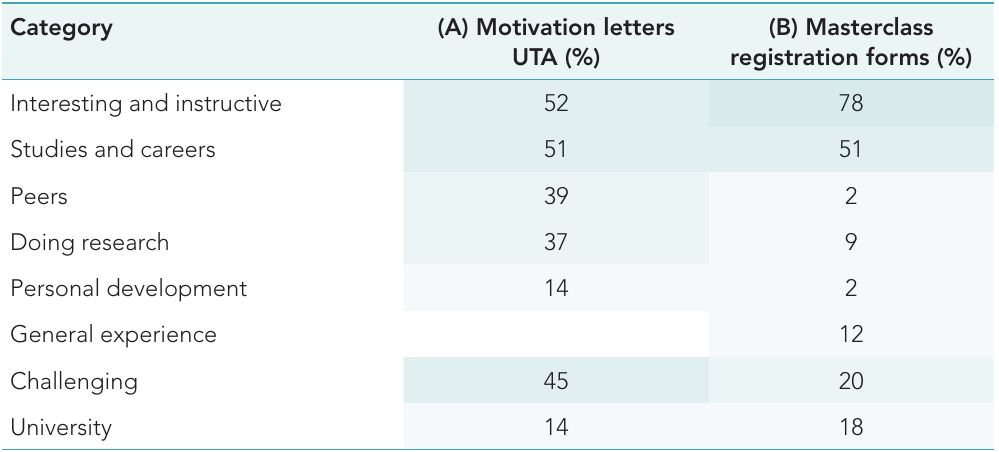
Table 4a: Overview of students’ motivation statements